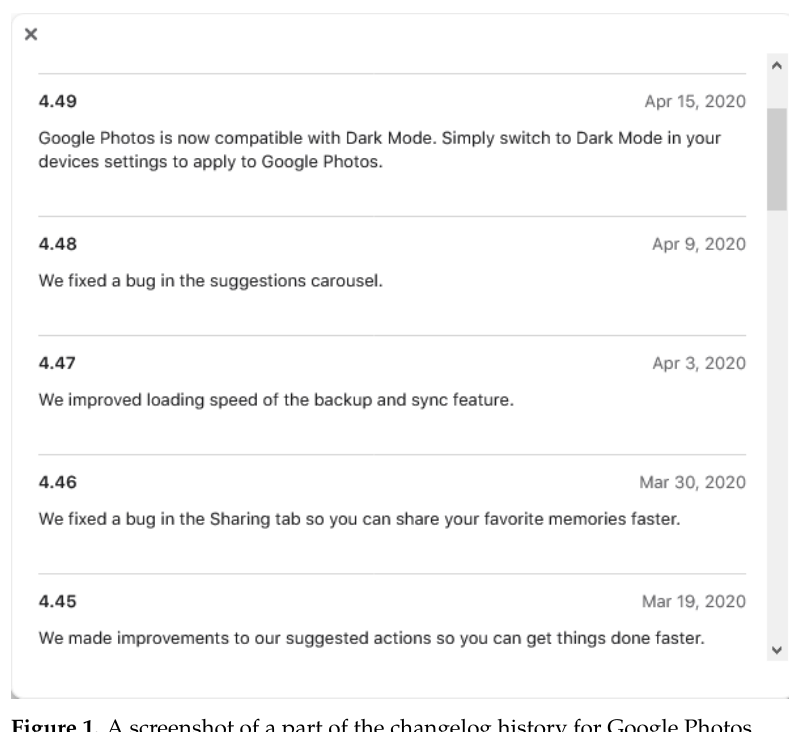
Figure 1. A screenshot of a part of the changelog history for Google